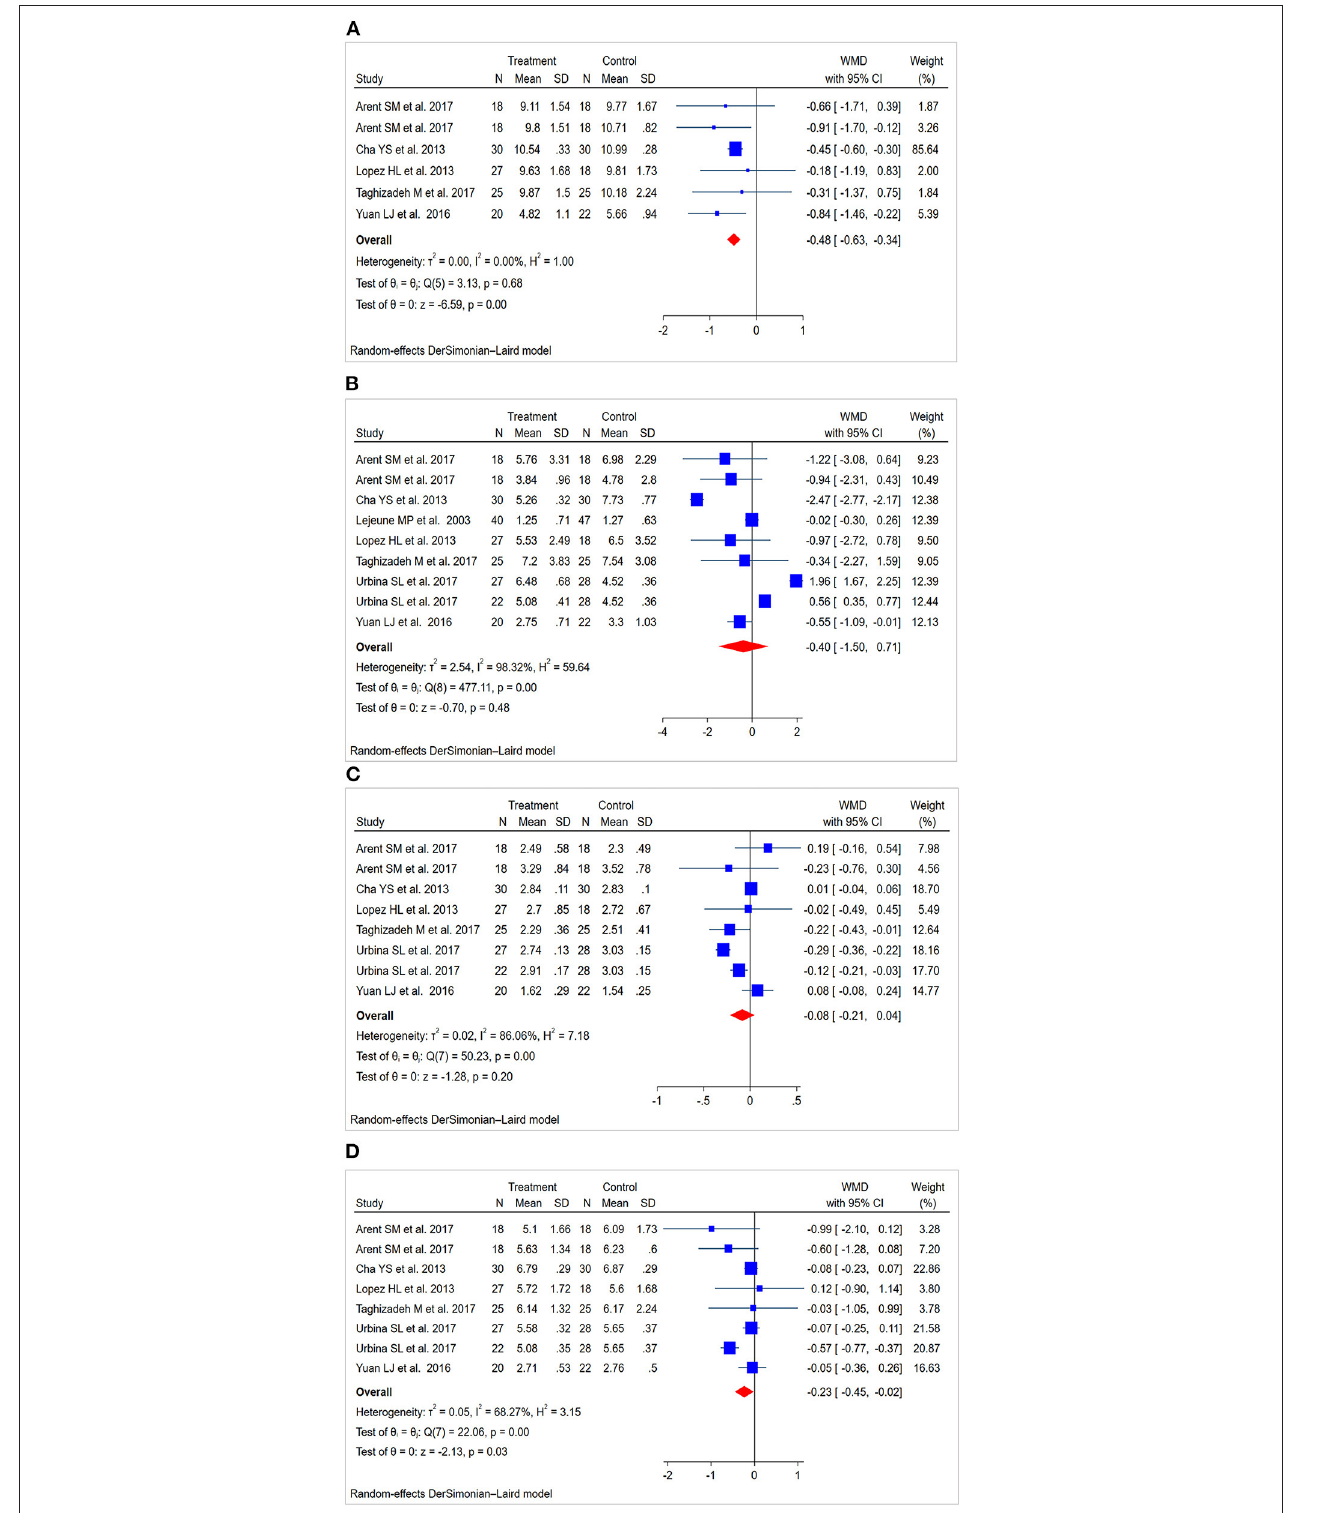
FIGURE 3 | Forest plot for lipid levels: capsaicin vs. placebo (random-effect model). (A) Funnel plot for total cholesterol (TC). (B) Funnel plot for triglycerides (TG). (C) Funnel plot for high-density lipoprotein cholesterol (HDL-C). (D) Funnel plot for low-density lipoprotein cholesterol (LDL-C).